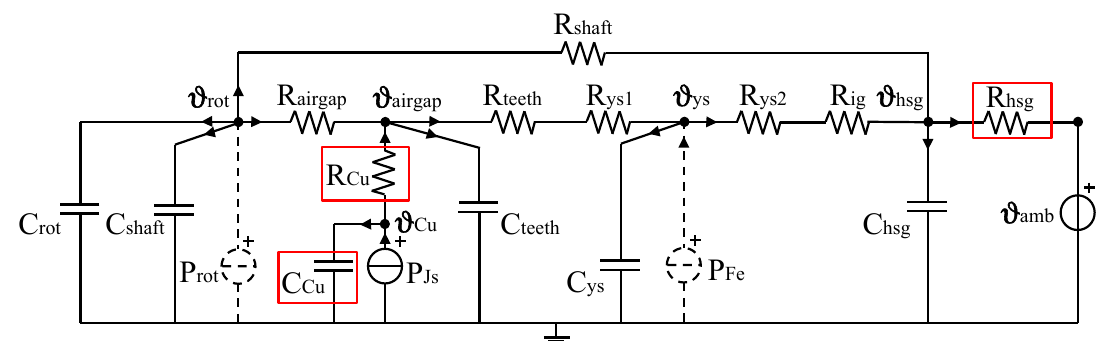
Figure 7. Conventional lumped-parameters thermal network for the temperature prediction of different parts of an electrical machine.